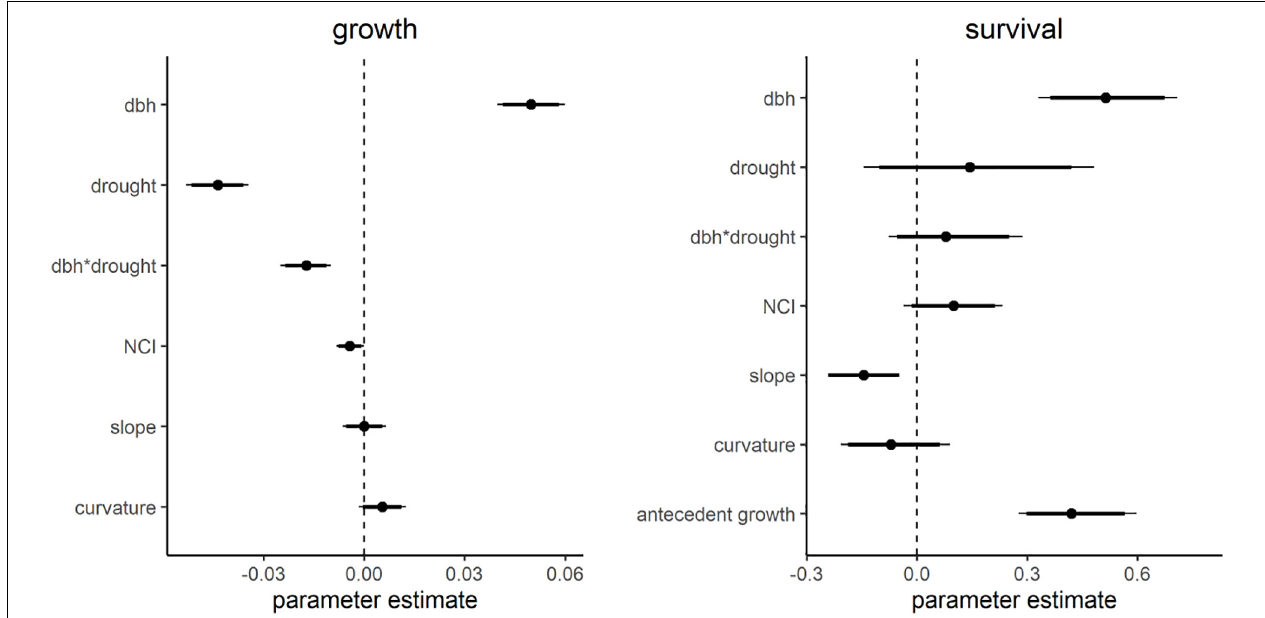
FIGURE 2 | Average parameters from the growth and survival models. Points indicate mean parameter estimates. Thicker lines show 90% credible intervals with thin tails showing 95% credible interval. Parameter values are b k (Eq. 3) i.e., average species effects. Parameters with credible intervals that did not overlap 0 were considered to be